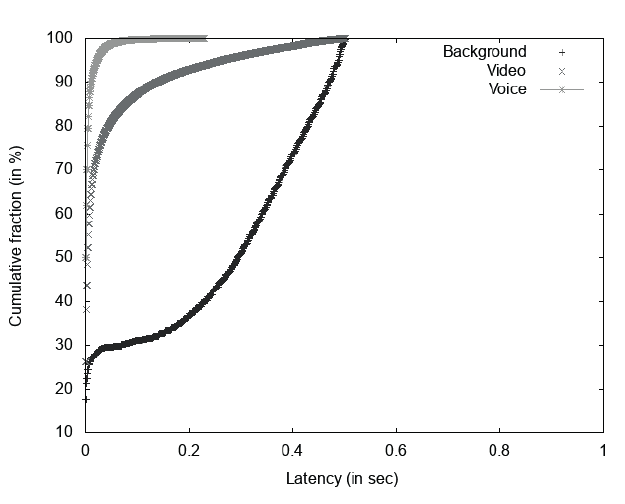
Fig. 9. CDF for NCA-EDCA.